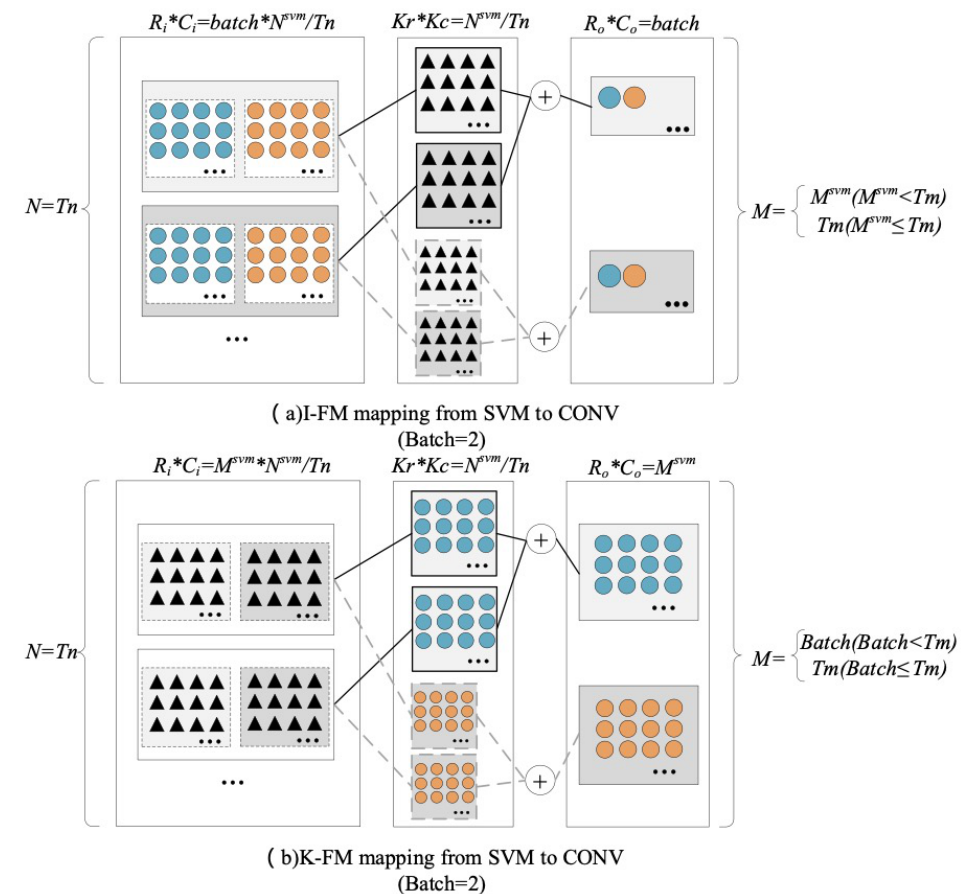
Figure 5. Computation mapping strategies of